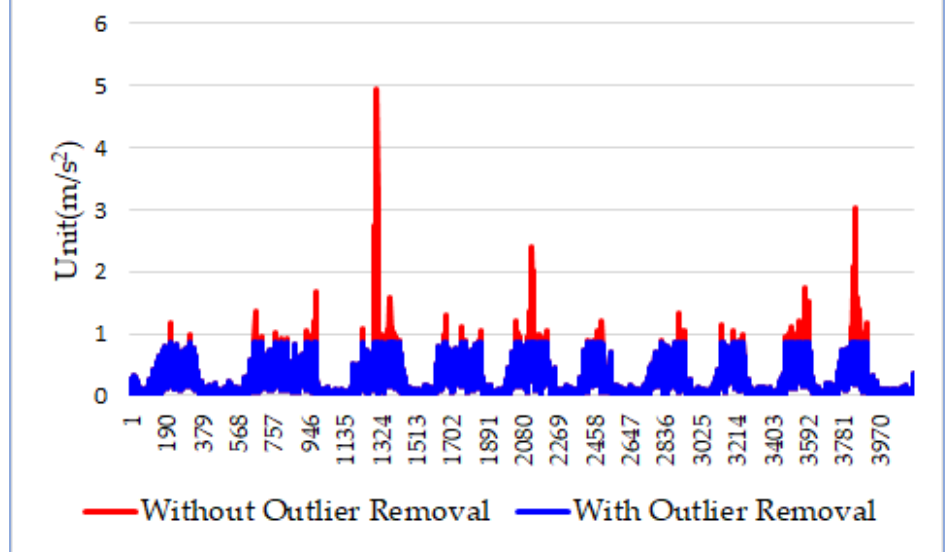
Figure 1. Outlier removal.